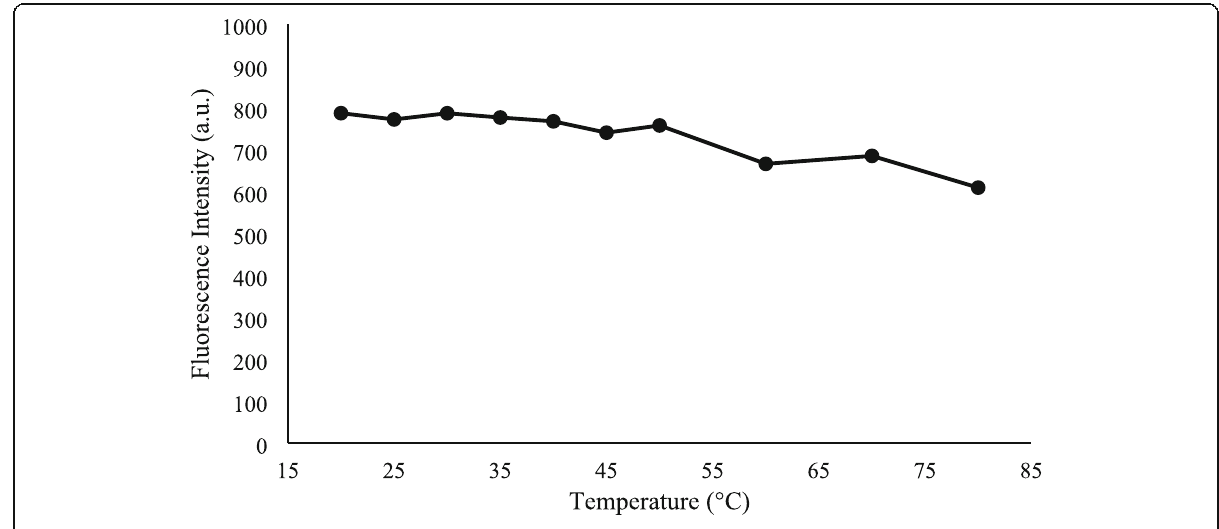
Fig. 7 Effect of temperature on native fluorescence intensity